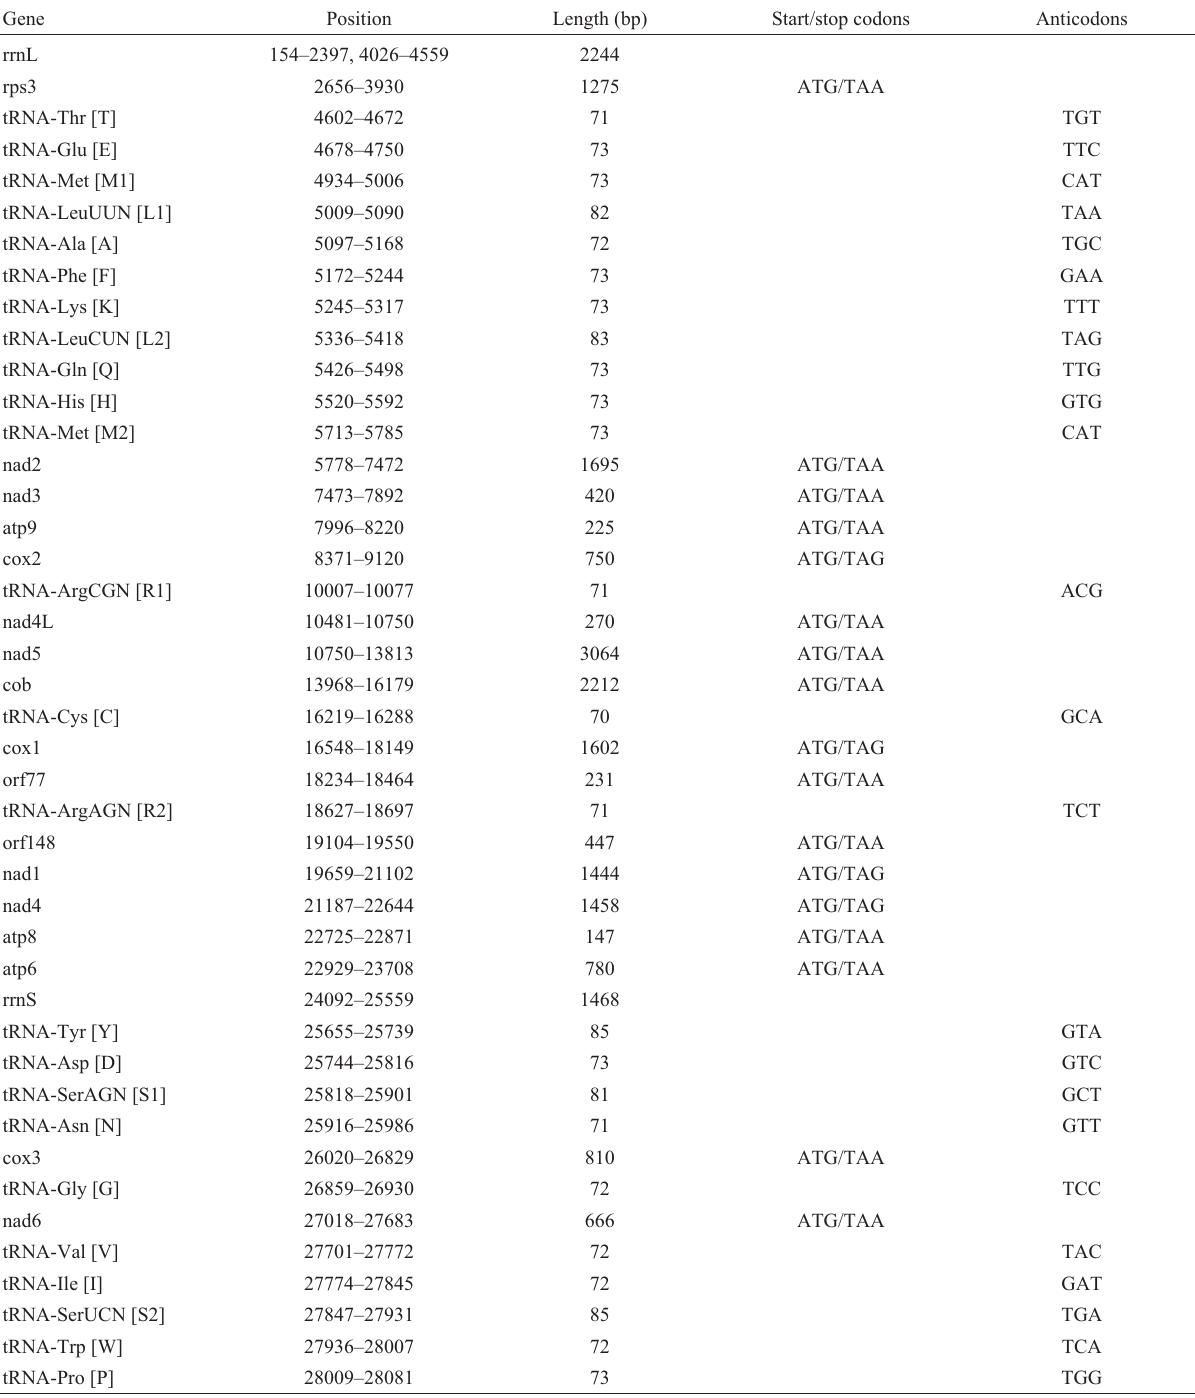
Table 1 - List of annotated mitochondrial genes in E.